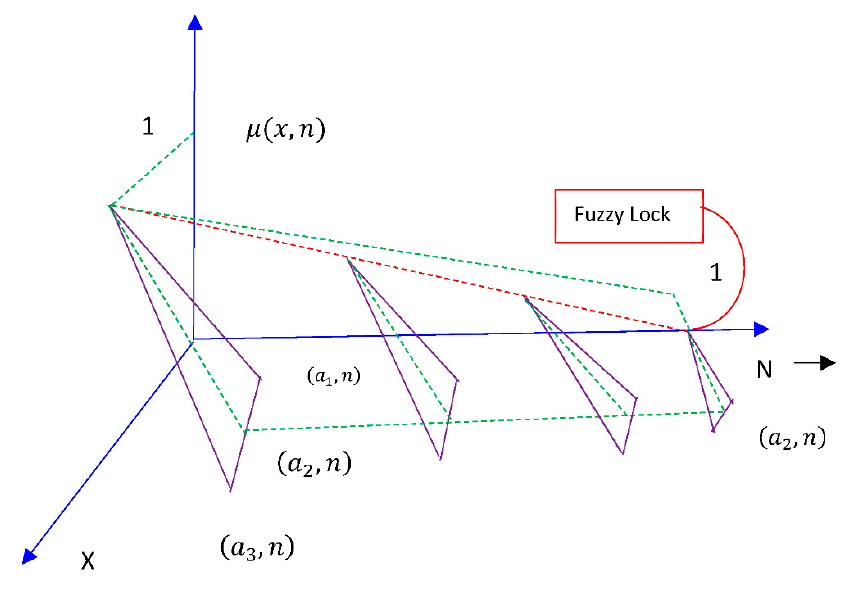
Figure 2. Membership function of triangular dense fuzzy lock sets (TDFLS).